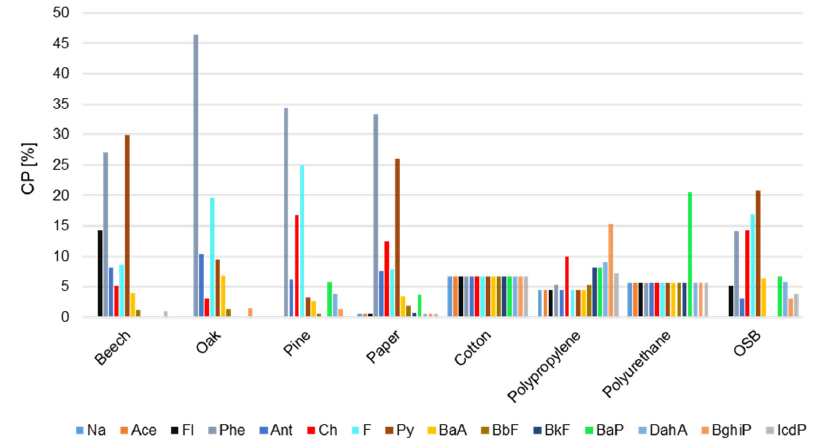
Figure 6. Carcinogenic potential (CP %) of individual compounds from the PM 4 -bound PAHs during burning of various types of materials.